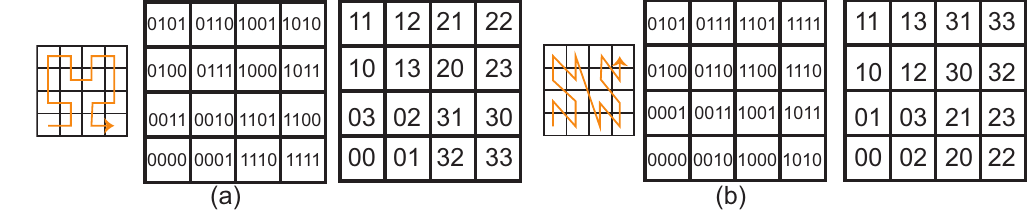
Figure 9. ( a ) (left) Hilbert space-filling curve (SFC); (middle) indexing with base two; (right) indexing with base four. ( b ) (left) Morton SFC; (middle) indexing with base two; (right) indexing with base